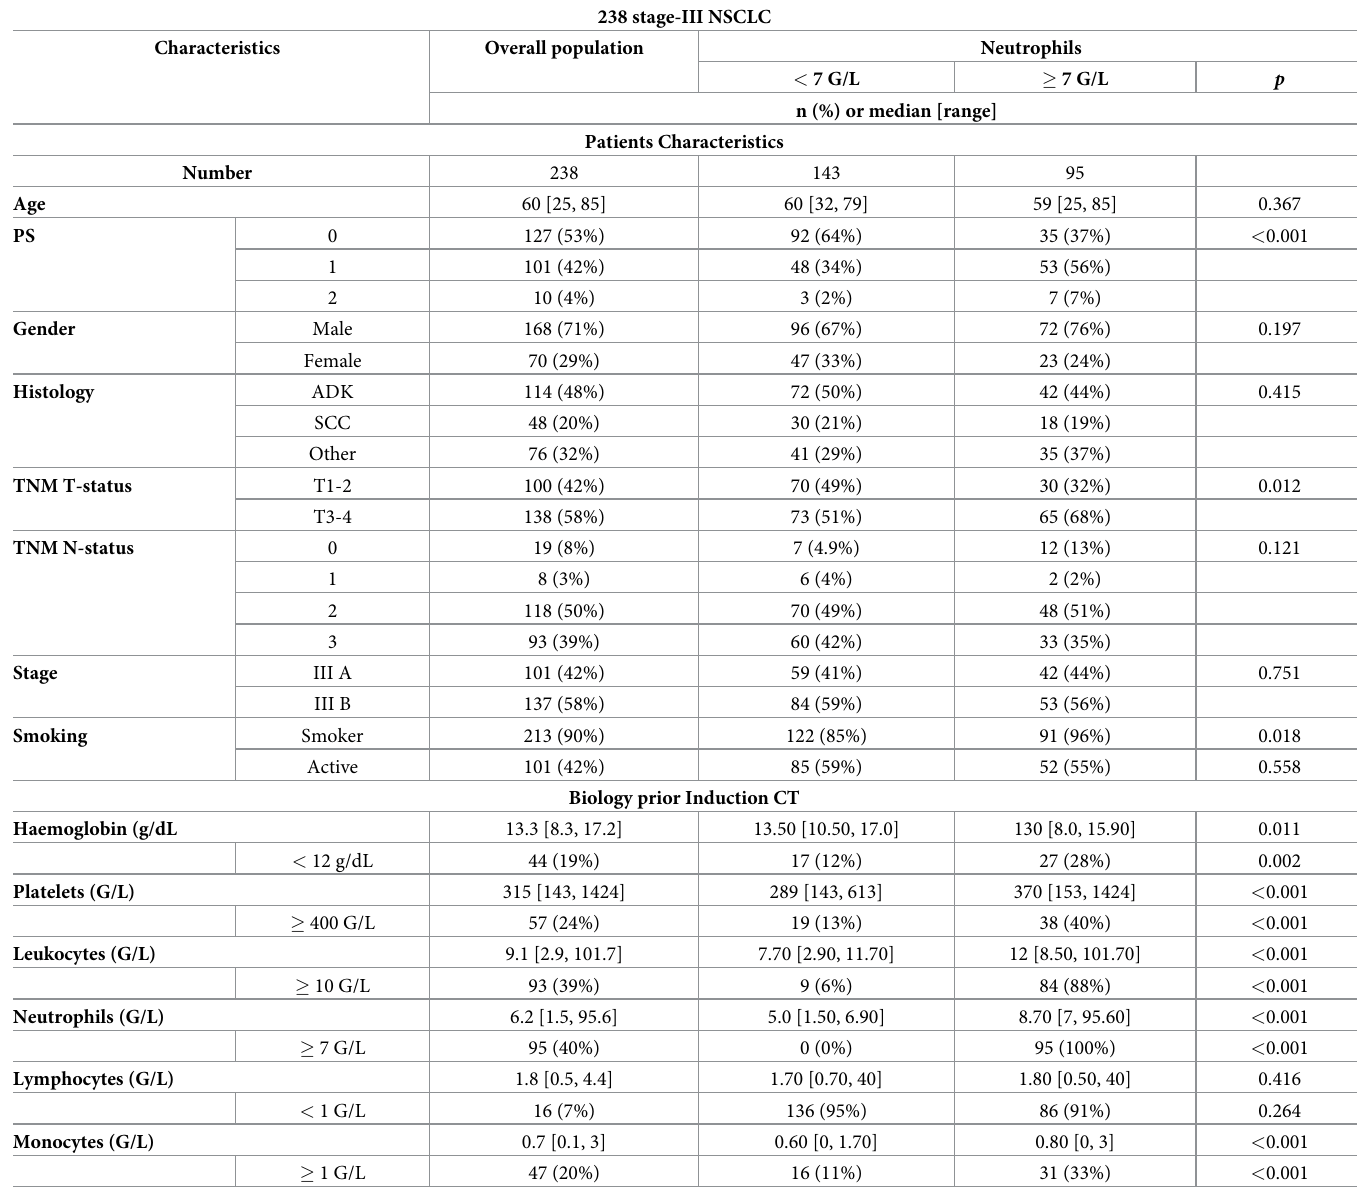
Table 1. Patients and tumor